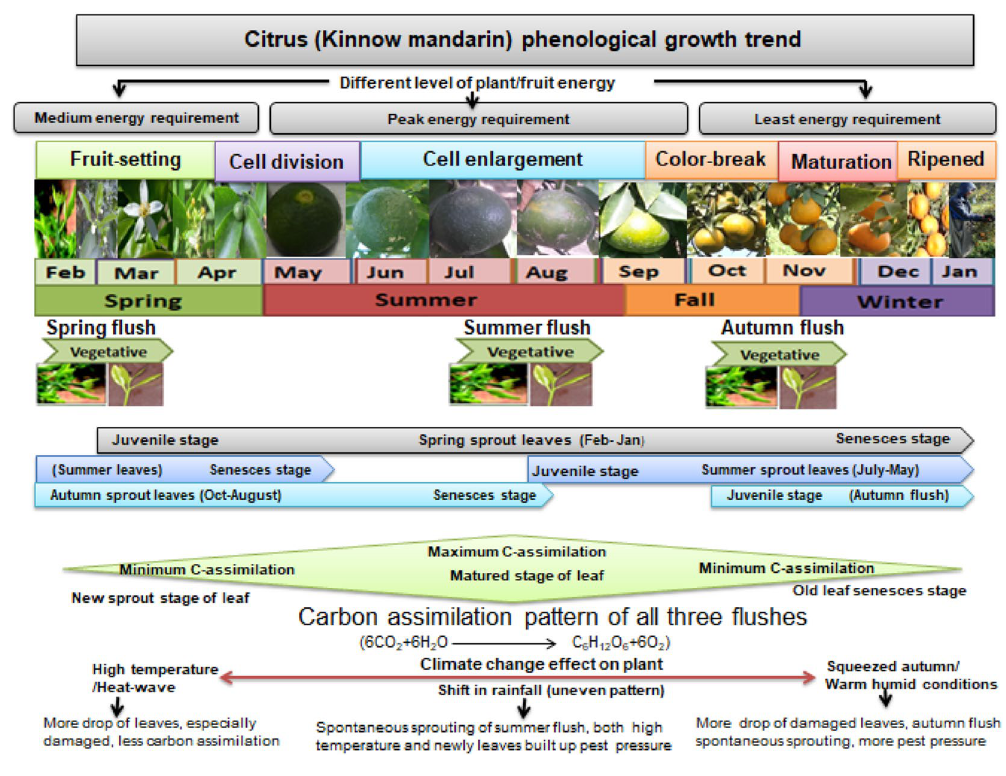
Figure 7. Phenological growth trend of citrus (Kinnow